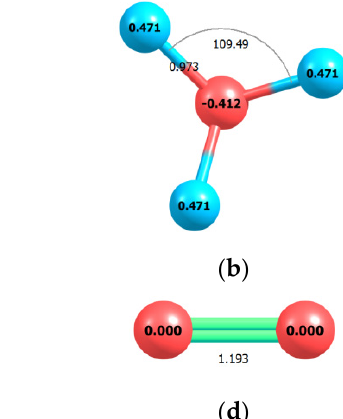
Figure A10. ( a ) The calculated geometric and electronic structure of 3-keto-2-carboxy- D -arabinitol 1,5-bisphosphate (3kCABP); Q = − 4, M = 1, E 0 = − 51,570.72 eV, G 0 = − 51,567.08 eV. Hessian has no negative frequencies. ( b ) The scheme of 2-carboxy-2,4-dihydroxy-3-oxopentane-1,5-diyl diphosphate.